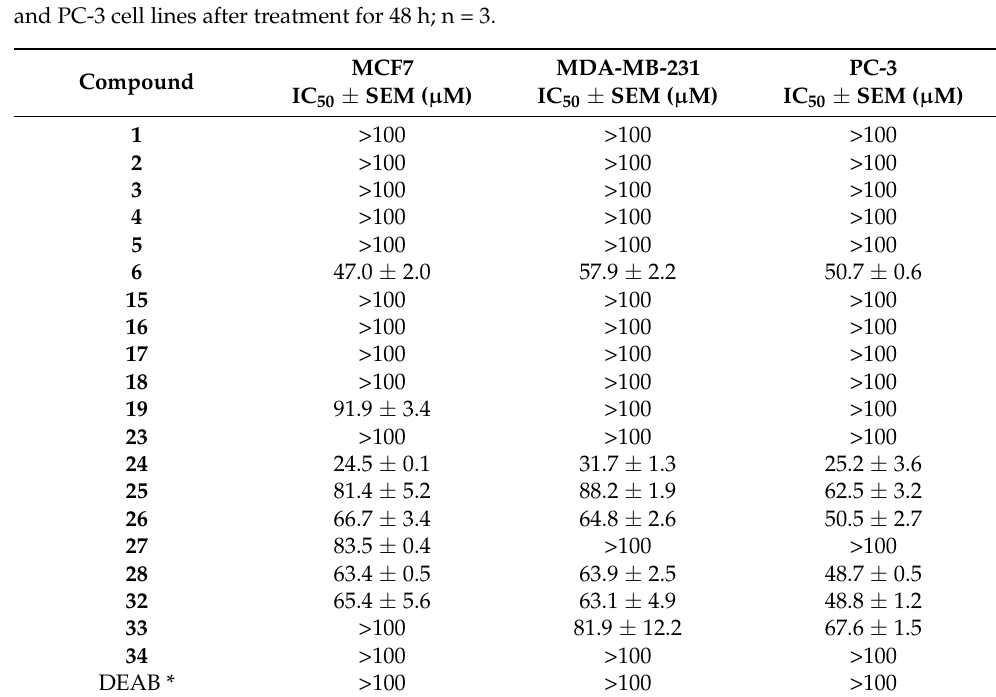
Figure 2. Western blot membranes showing the expression of ( a ) ALDH1A3 enzyme and ( b ) GAPDH loading control on MDA-MB-231, MCF7, and PC-3 cell lines. Table 1. Cytotoxicity (IC 50 ± SEM) of 1 – 6 , 15 – 19 , 23 – 28 , 32 – 34 , and DEAB on MCF7, MDA-MB-231, and PC-3 cell lines after treatment for 48 h; n =